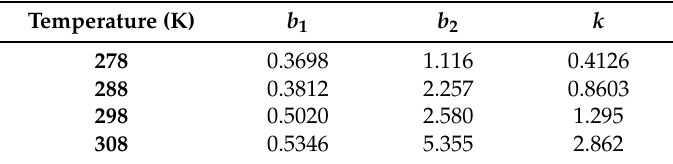
Table 3. Kinetic parameters of the estimated model.